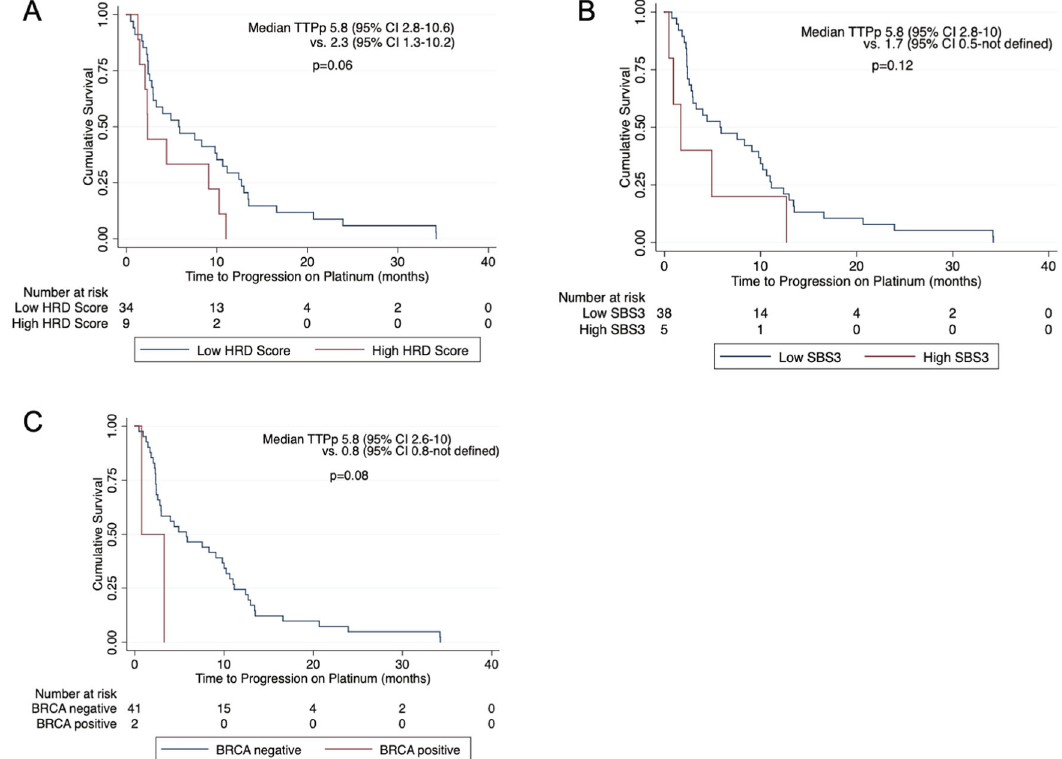
Fig. 5 Kaplan – Meier time to progression on platinum curves for patients with metastatic thoracic malignancies. Curves are strati fi ed by HRD score ( A ), SBS3 exposure ( B ), and BRCA status ( C ).